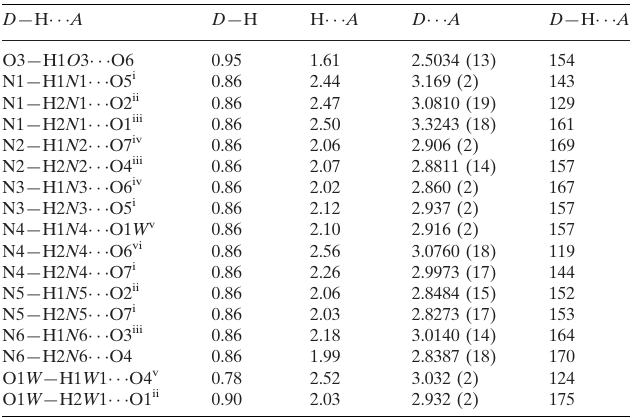
Hydrogen-bond geometry (A˚ , (cid:4)